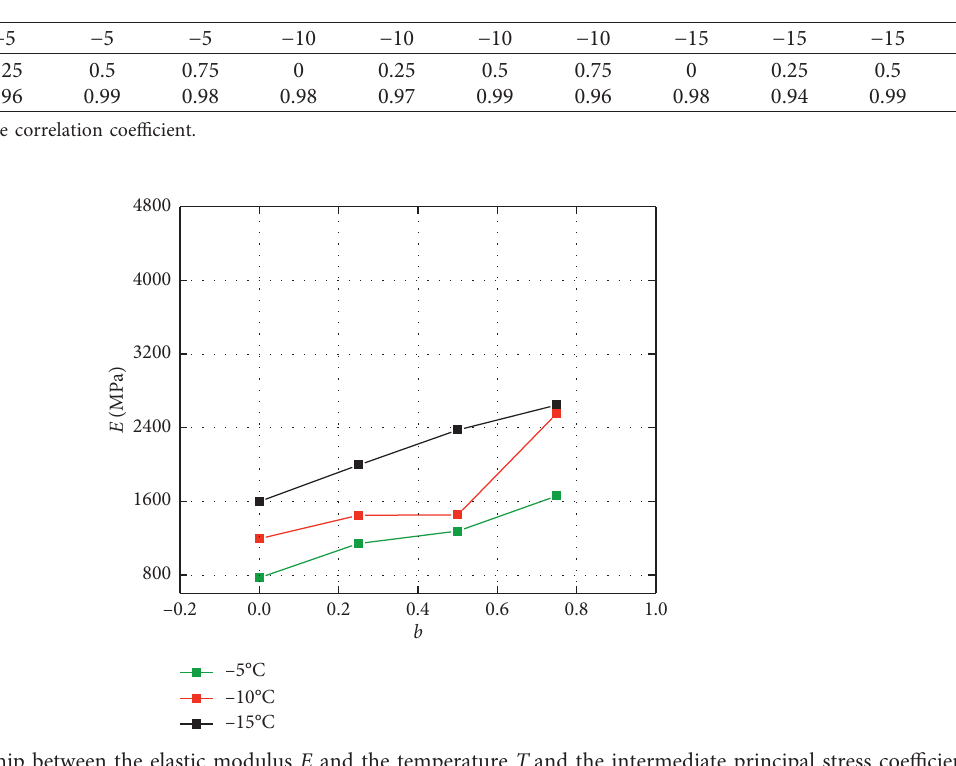
Table 2: Correlation coefficients of experimental and theoretical curves at different temperatures and intermediate principal stress coefficients.